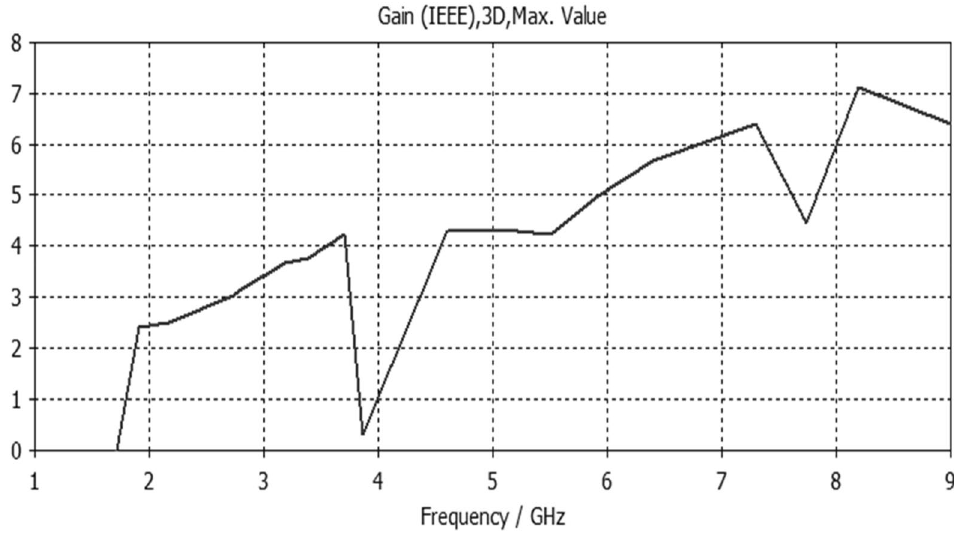
Figure 12. Gain result for Antenna4.